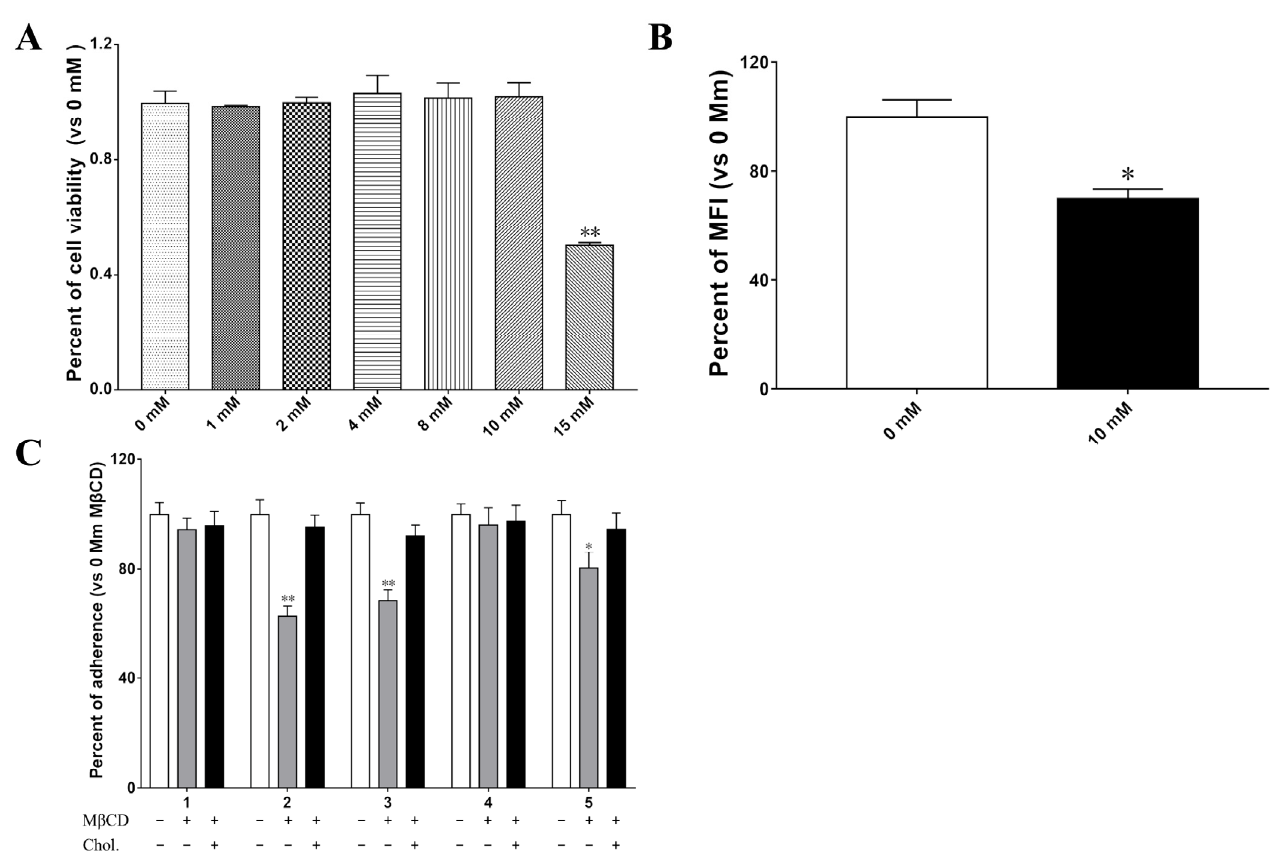
Figure 7. Membrane cholesterol is important for LT-increased ETEC 1836-2 adhesion to IPEC-J2 cells. ( A ) Different concentrations of M β CD effects on cell viability of IPEC-J2 cells. The viability of untreated IPEC-J2 was assumed to be 100%. ( B ) Cholesterol removal efficiency after treating IPEC-J2 cells with 10 mM M β CD. The mean fluorescence intensity (MFI) of the untreated IPEC-J2 cells was assumed to be 100%. ( C ) Pre-treated IPEC-J2 cells with M β CD blocks LTB-enhanced bacterial adherence. The adhesion index of ETEC 1836-2 strain to untreated IPEC-J2 cells was assumed to be 100%. Data are expressed as mean ± SD of triplicate independent experiments. * indicates p < 0.05 and is deemed statistically significant. ** indicates p < 0.01 and is deemed statistically highly significant.